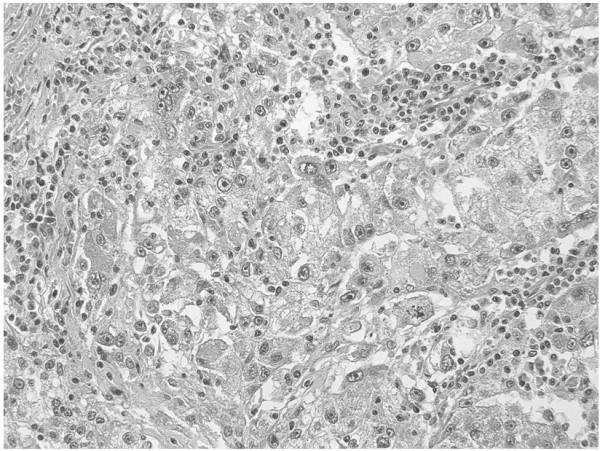
Hematoxylin-eosin stained section. The pathological findings indicate clear cell renal cell carcinoma with necrosis, hyaline degeneration, and hemosiderosis (magnification: ×200).